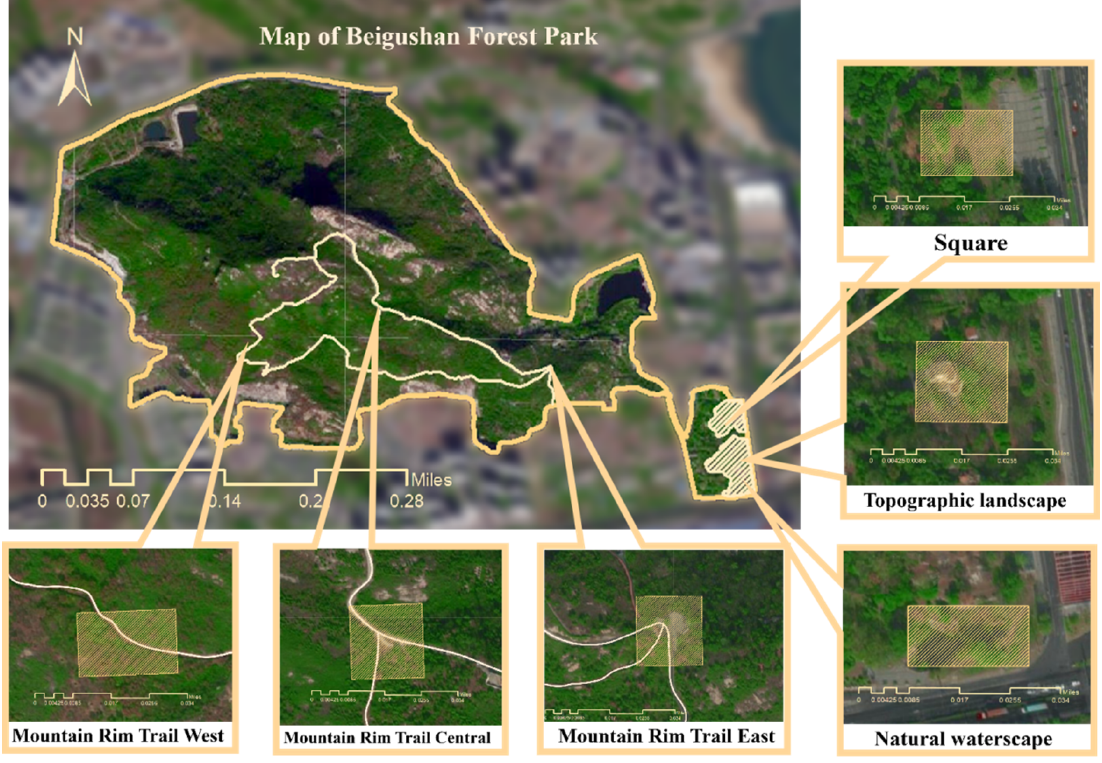
Figure 2. Sampling point distribution map.